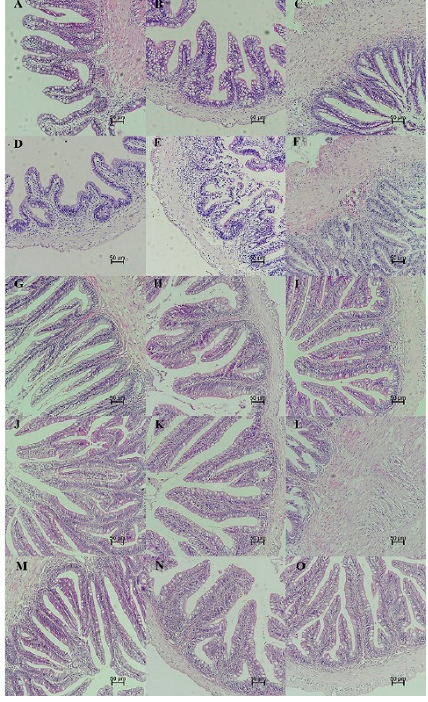
Figure 12. Photomicrographs showing histological sections of the intestinal tract of mandarin fish in different feeding groups (LBFD, PFD, PFDCB, PFDLR and PFDLP) after being fed for 28 days. (H.E. staining; scale bar: 50 μ m; magnification ×200). ( A – C ) Foregut, midgut and hindgut of mandarin fish in LBFD group. ( D – F ) Foregut, midgut and hindgut of mandarin fish in PFD group. ( G – I ) Foregut, midgut and hindgut of mandarin fish in PFDCB group. ( J – L ) Foregut, midgut and hindgut of mandarin fish in PFDLR group. ( M – O ) Foregut, midgut and hindgut of mandarin fish in PFDLP group. Abbreviations: H.E., hematoxylin and eosin staining; LBFD, live bait fish feeding group; PFD, pellet-feed feeding group with probiotics free; PFDCB, pellet-feed feeding group with C. butyricum plus; PFDLR, pellet-feed feeding group with L. rhamnosus plus; PFDLP, pellet-feed feeding group with L. plantarum plus.